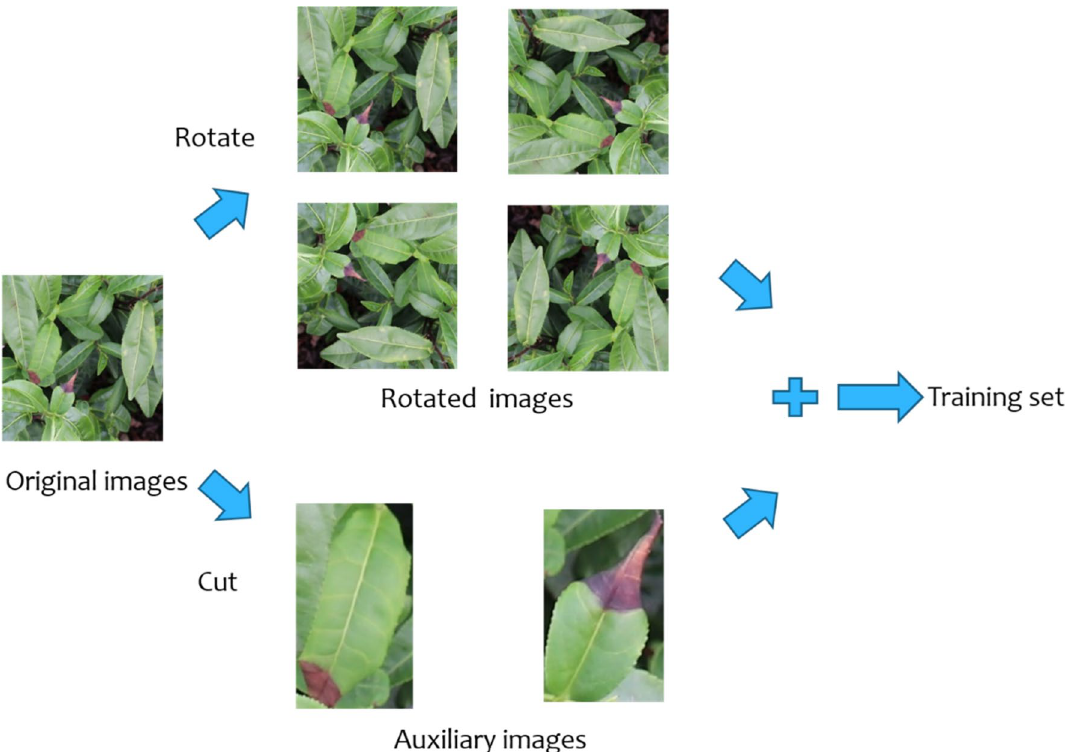
Figure 2. Schematic diagram of image augmentation